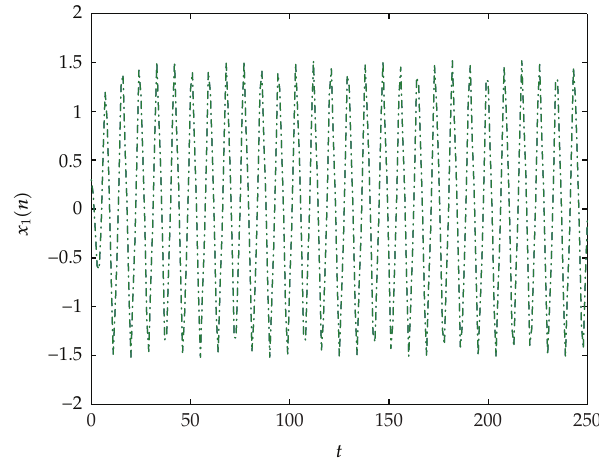
Figure 5: An invariant closed circle bifurcates from equilibrium (cid:2) 0 , 0 (cid:3) . The initial value and parameter D are (cid:2) 2 , 3 (cid:3) and 14 / 3,